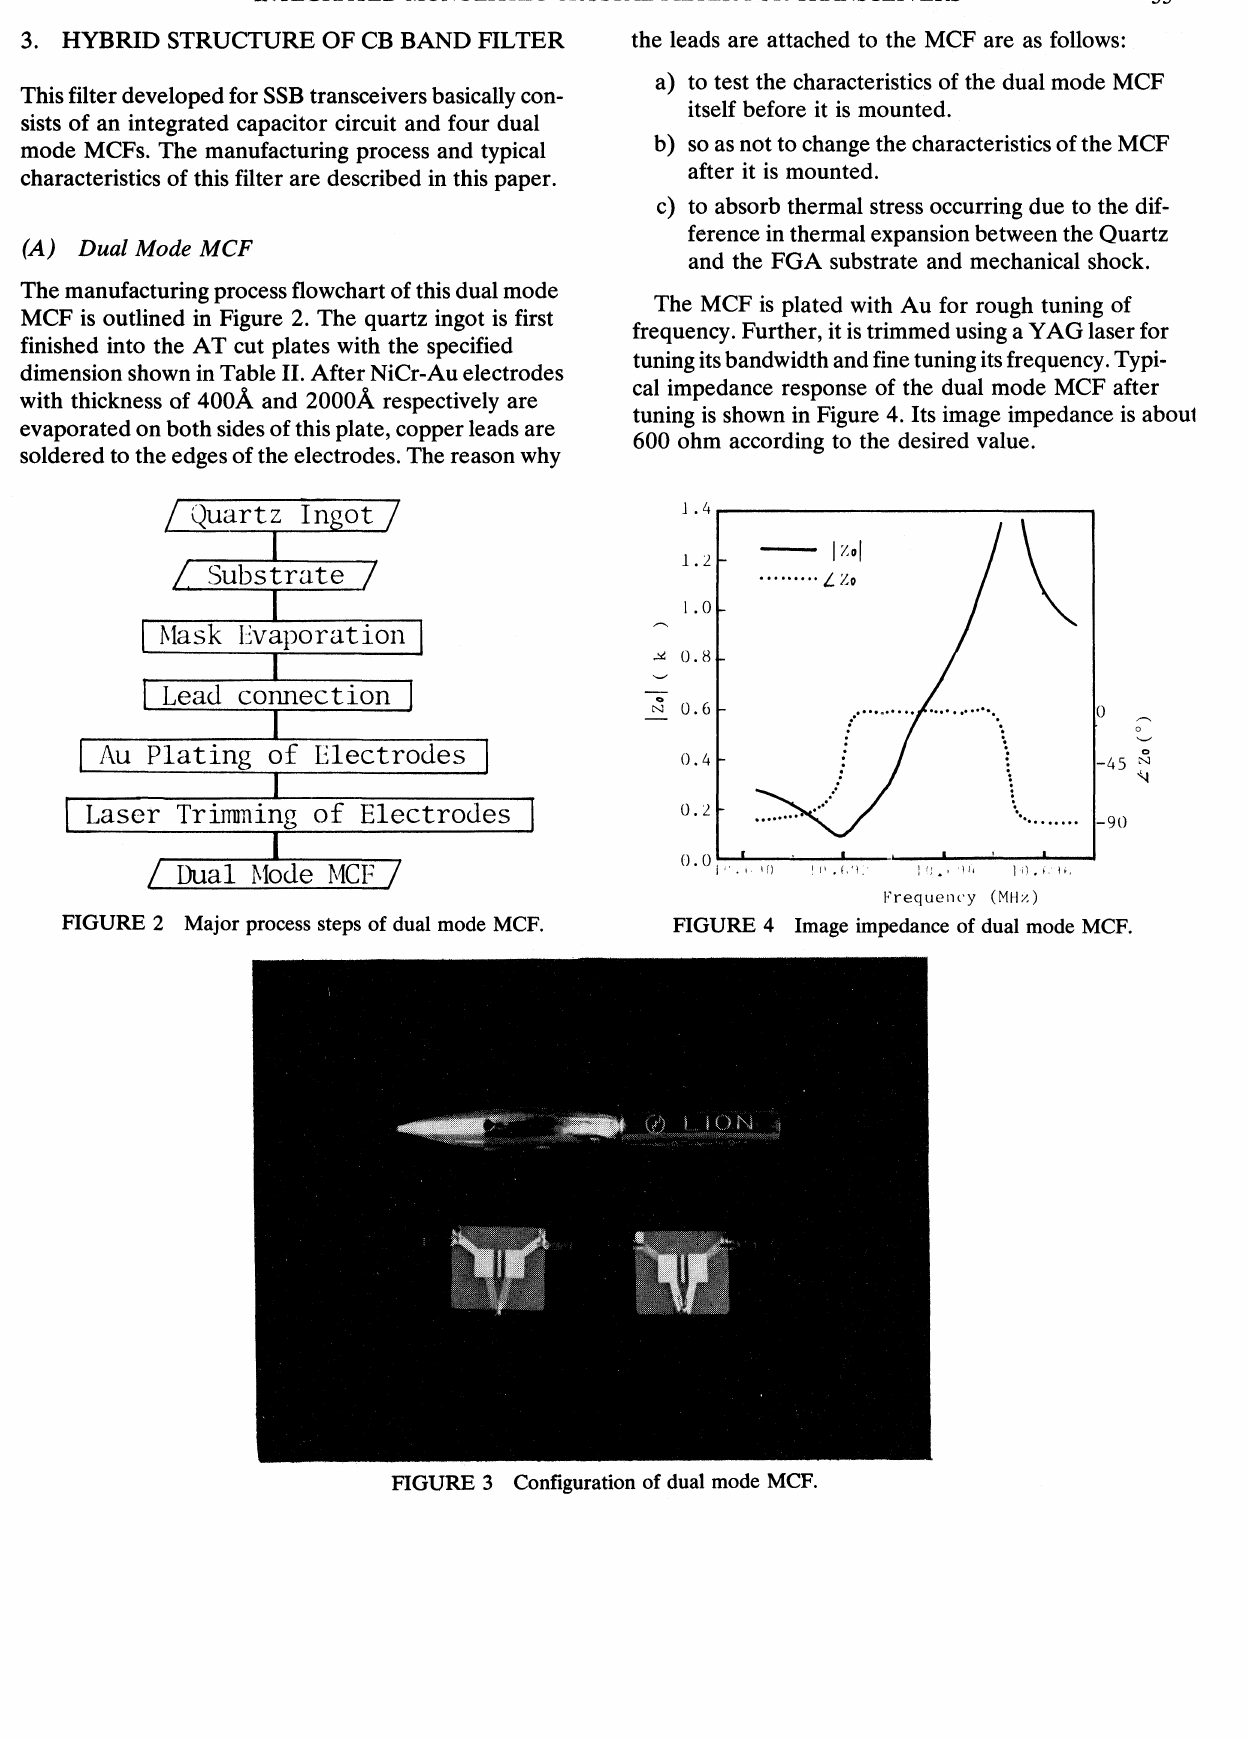
FIGURE 3 Configuration of dual mode